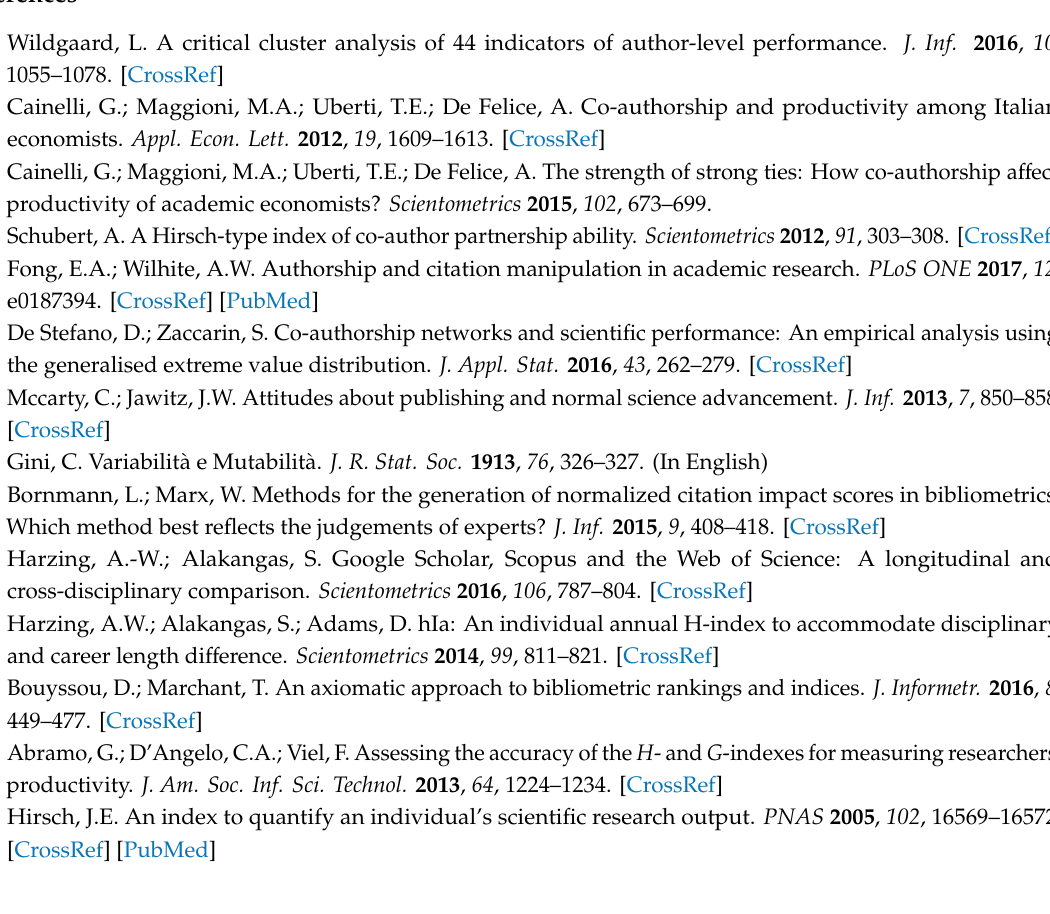
Figure A2. Characterization of a randomly chosen author for health sciences. Black area (15.3%) = networking; red area (0.2%) = intradisciplinary and intratopical heterodox; yellow area (86.2%) = intradisciplinary and intertopic orthodox; blue area (0%) = interdisciplinary and intertopical orthodox. G d = 0, G j = 0.97, H ldn = 0.03, H ljn = 1.00, H ltn = 1.10, H ltg = 1.30. Abbreviations: G d , Gini index for disciplines; G j , Gini index for journals; H , Hirsch indexes; d = discipline, g = gross, j = journal, l = linear, n = net, t = total.